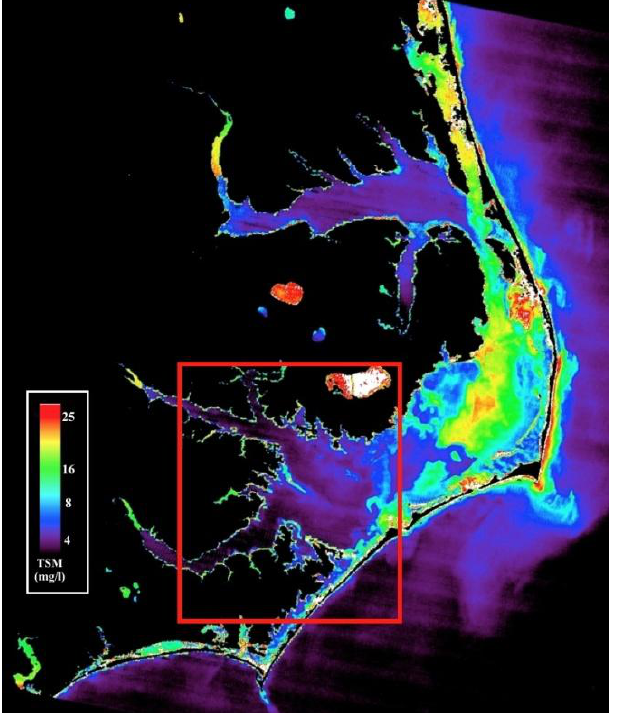
Figure 3. MODIS 250 m TSM image for 24 November 2010 showing extremely low TSM concentrations in the area imaged by Landsat 7 ETM+ and FOMOSAT-2 RSI sensors (red box) following the passage of two storms in the Neuse and Tar River